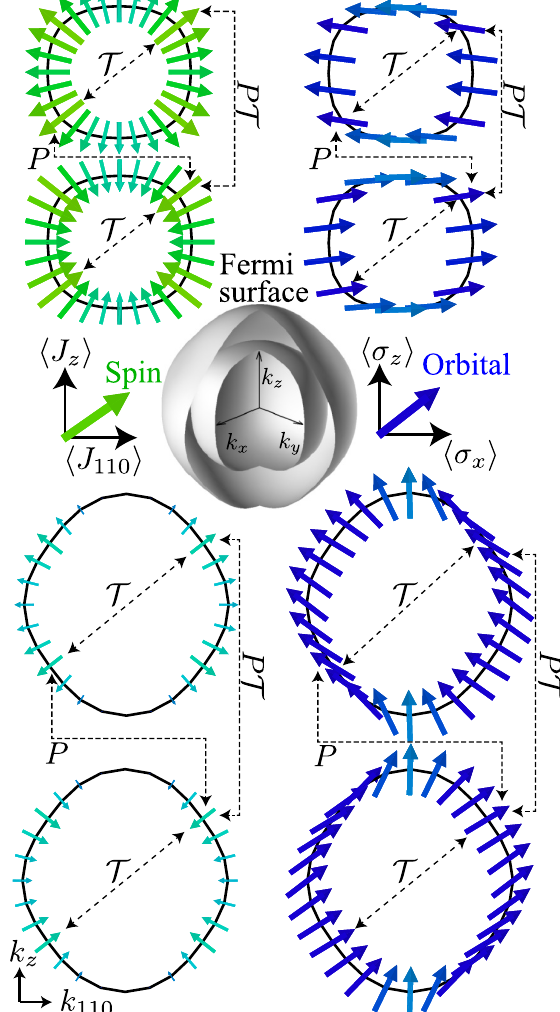
FIG. 3. (Center) Fermi surfaces of antiperovskites. For μ < − m 0 , there are two Fermi surfaces. The top and bottom panels show the spin and orbital textures of the inner and outer Fermi surfaces, respectively. The green (blue) arrow represents the expectation value of the spin (orbit). The dashed arrows indicate T , P , and P T partners. The parameters are μ ¼ − 2 m 0